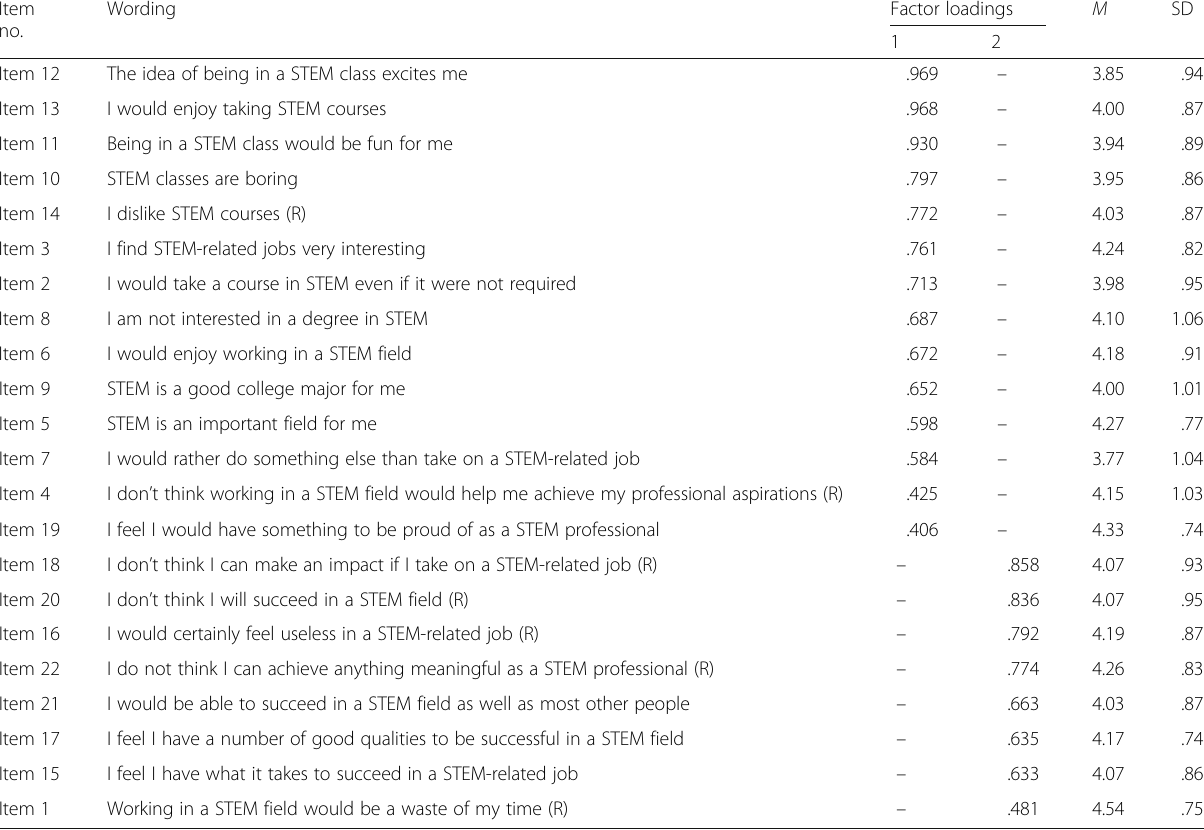
Table 8 Rotated factor loadings (second factor analysis), means, and standard